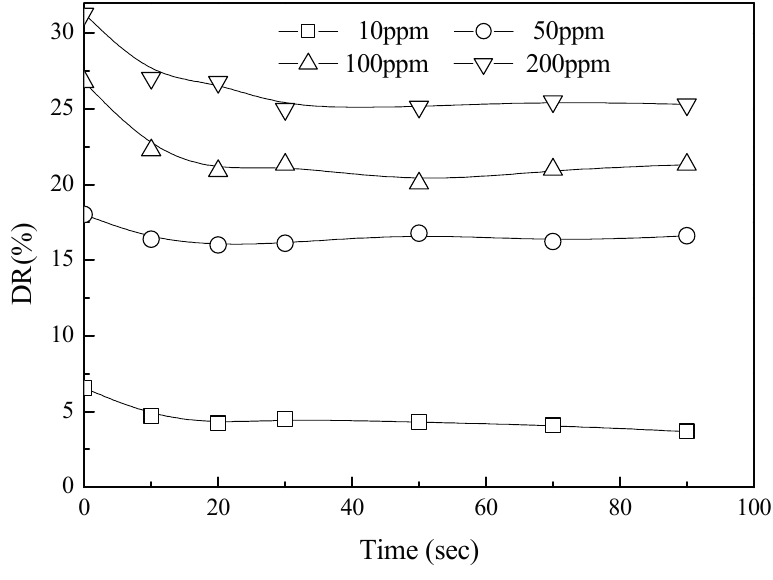
Figure 7. Drag reduction versus time with virgin guar gum and different concentrations (Reprinted from